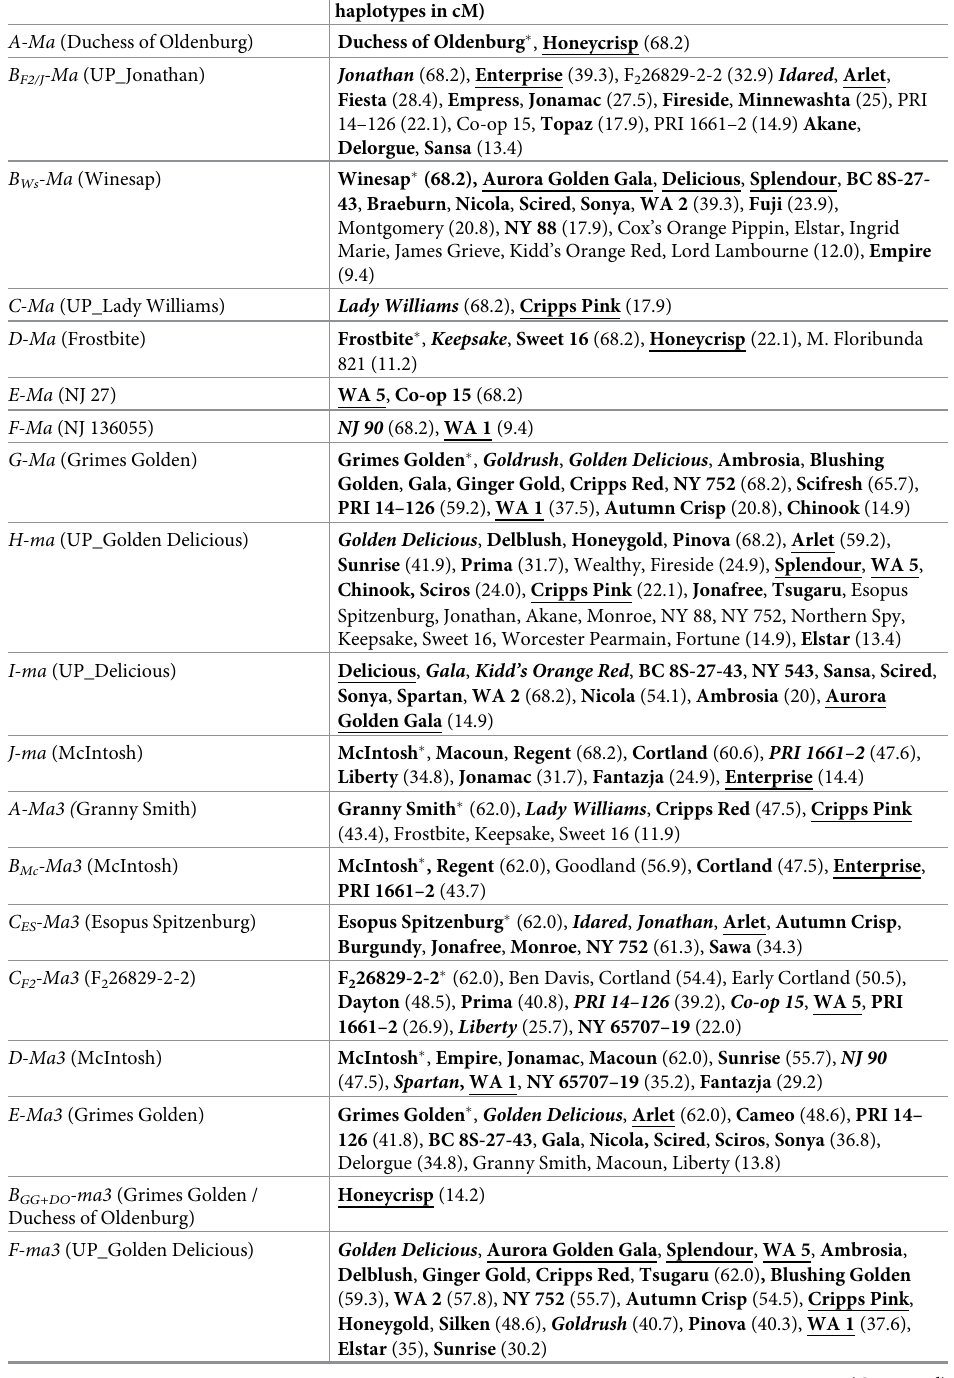
Table 2. Alleles deduced at the acidity trait loci Ma and Ma3 for apple cultivars and selections by haplotype sharing. Allele (ancestral